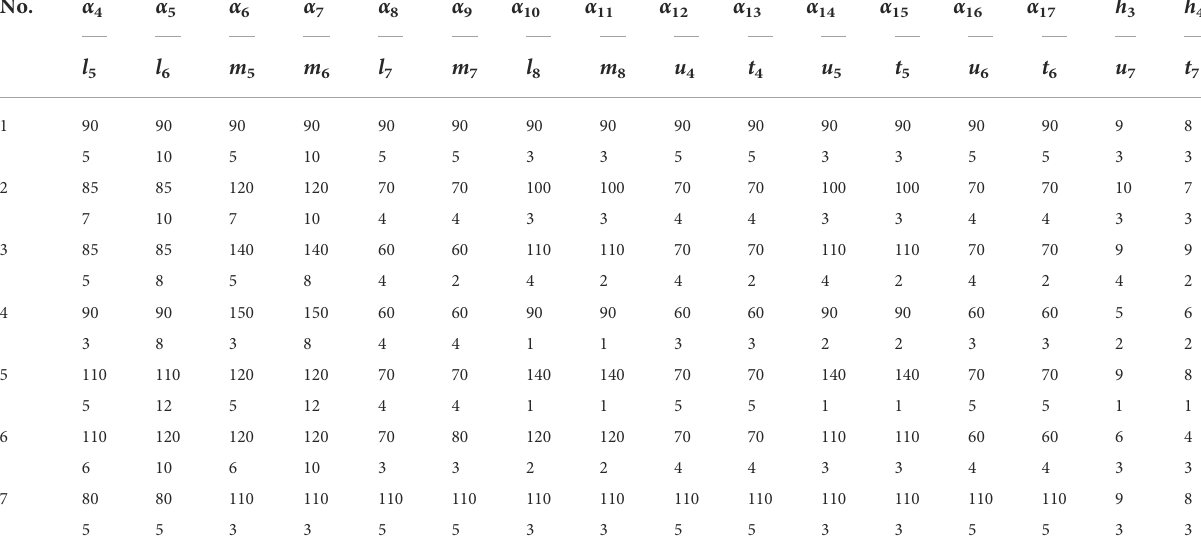
TABLE 1 Parameters of the interest region (Unit of length: mm; Unit of Angle: ° ). No.